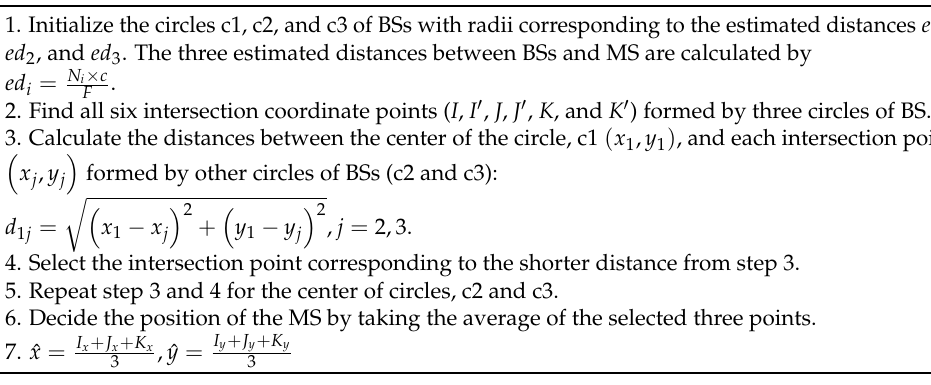
Figure 3. The shortest distance algorithm. Table 1. Summary of the shortest distance